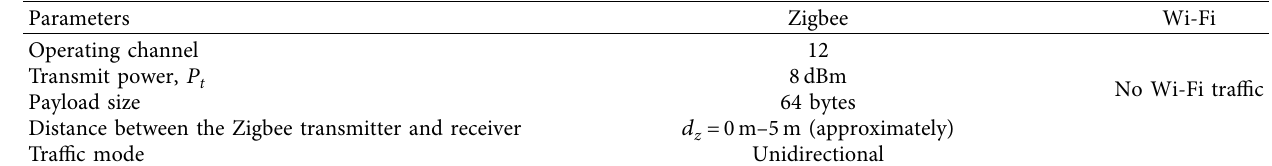
Figure 3: Testbed topologies: (a) Zigbee without a nearby Wi-Fi network. (b) Zigbee with a nearby Wi-Fi Table 2: Parameters for the experiments in Section 4.1.1.